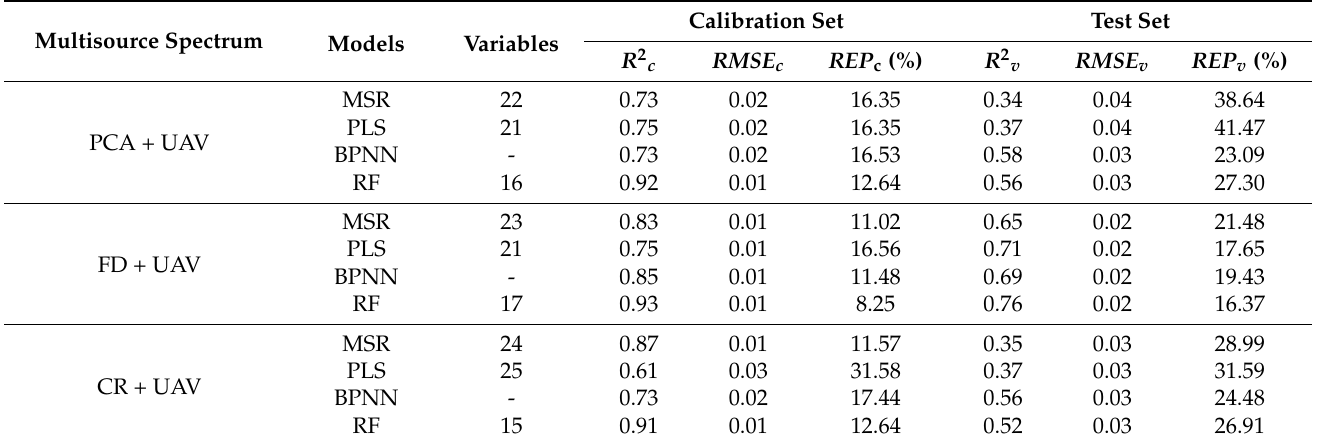
Table 9. Multisource remote sensing (RS) Anth estimation